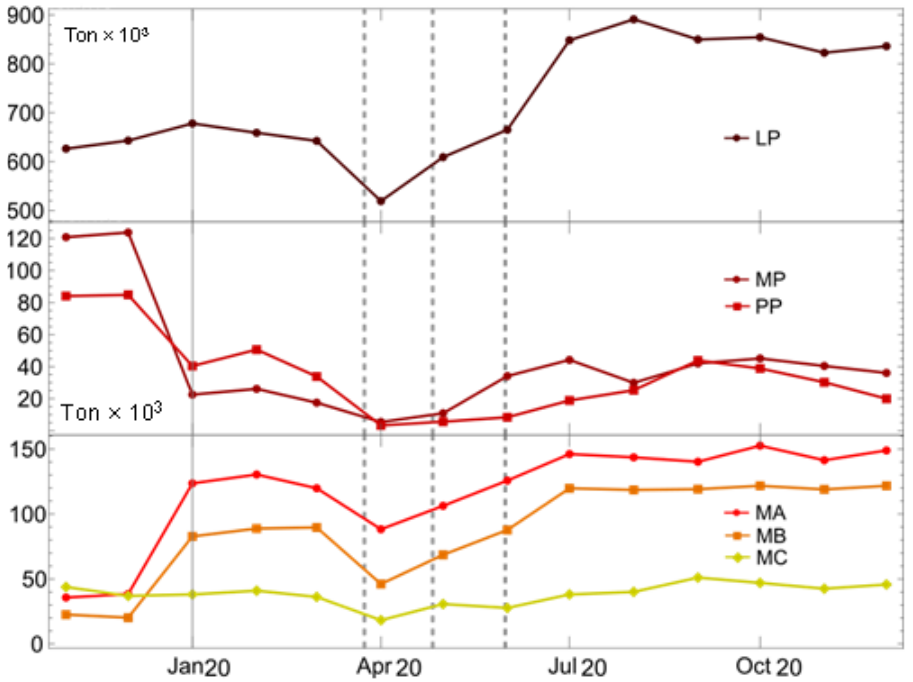
Figure 2. Bio-sanitary waste disposal series at the Bogotá sanitary landfill. The first panel shows biosanitary residues for the year 2020 for large producers (LPs), the second panel shows medium producers (MPs) and small producers (PPs), and the third panel shows micro-producers A, B, and C in red, orange and yellow, respectively.